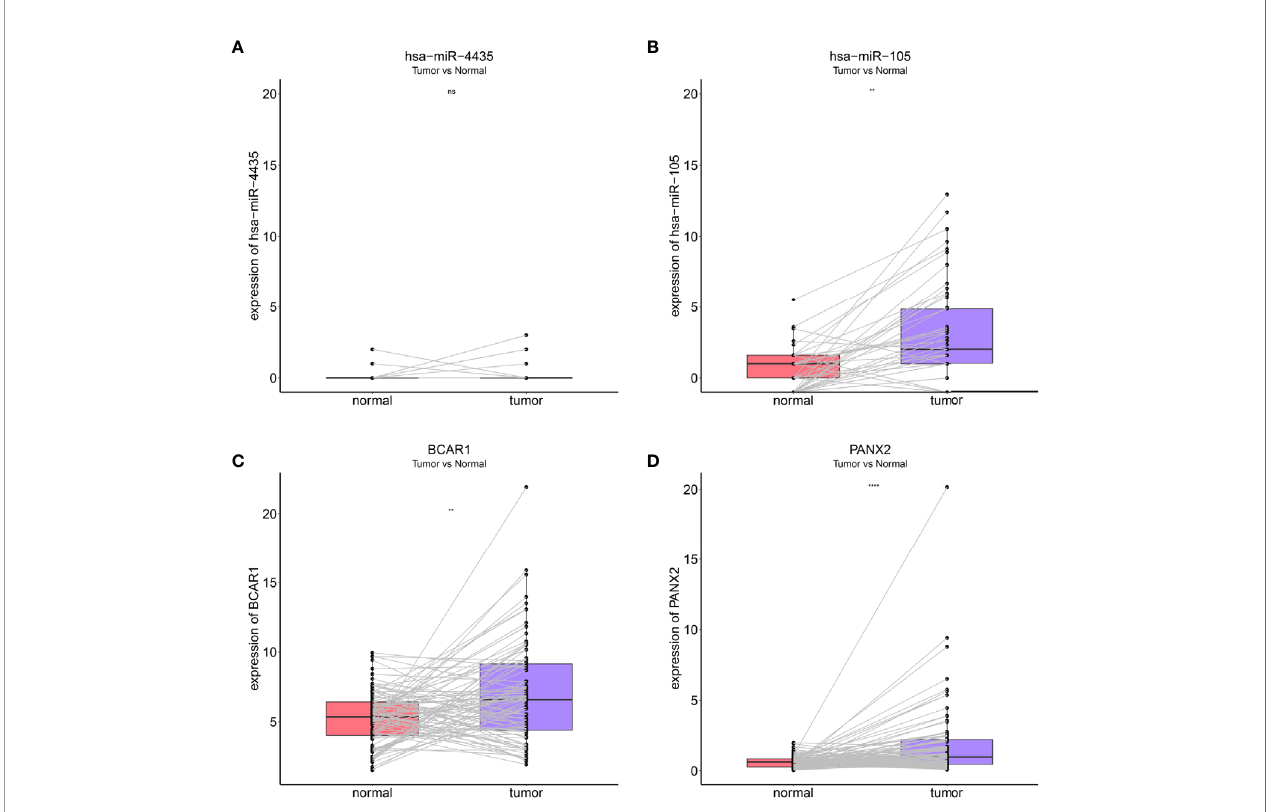
FIGURE 9 | Expression levels of the 4 reliably metastatic biomarkers between 87 cancer tissues and 87 paired paracancerous tissues. hsa-miR-4435 (A) , hsa-miR- 105-5p (B) , BCAR1 (C) , PANX2 (D) . **P < 0.01 and ****P < 0.0001, NS, not signi fi